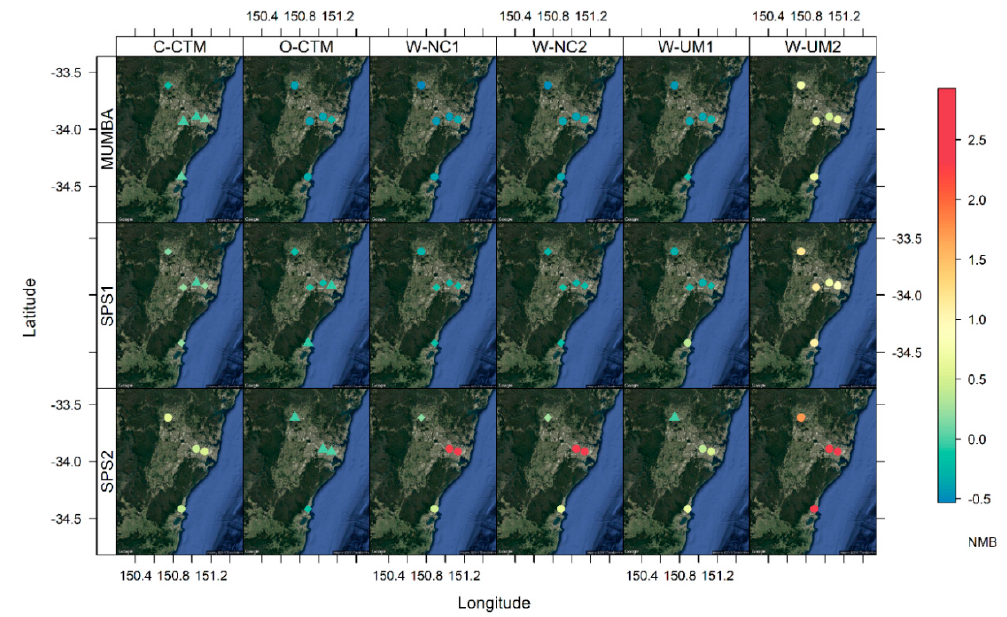
Figure 10. Model performance in terms of normalized mean bias (NMB) across the domain. Sites at which the NMB criteria is exceeded (NMB < ± 30%) are shown as diamonds. Sites at which the goal is met (NMB < ± 10%) are shown as triangles.